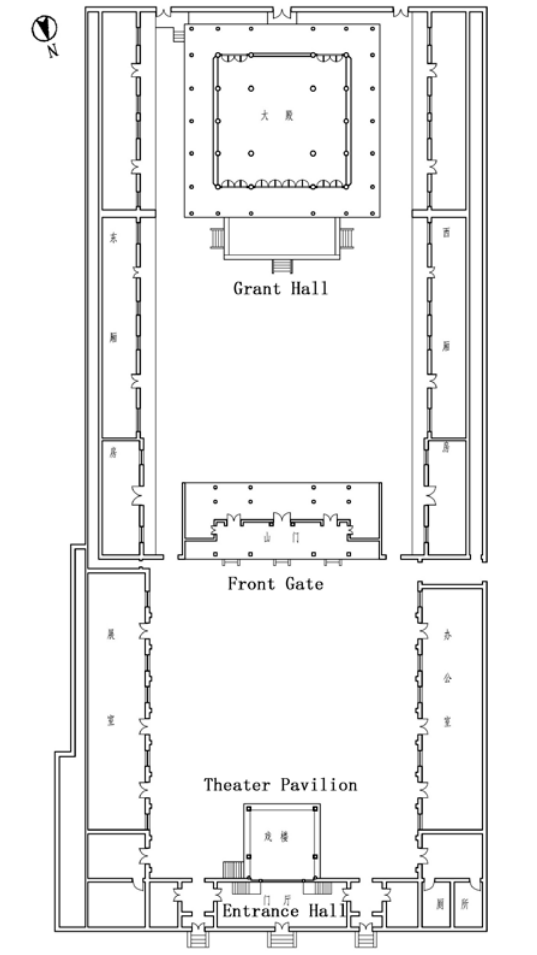
Figure 3. Overall Layout of the Hall of